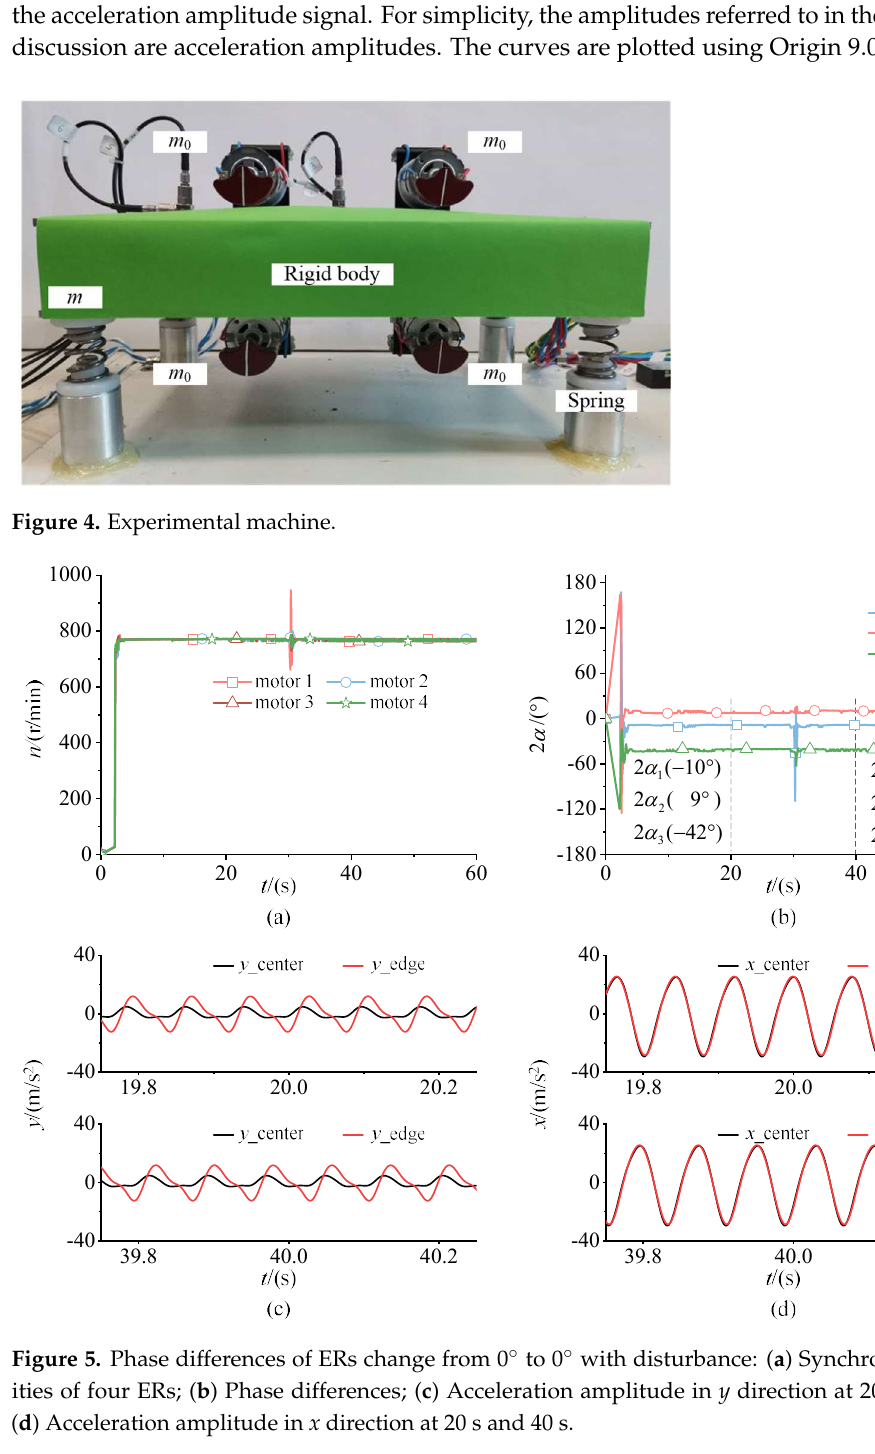
Figure 6. Phase images of four ERs in sub-resonant state during one period of motion.